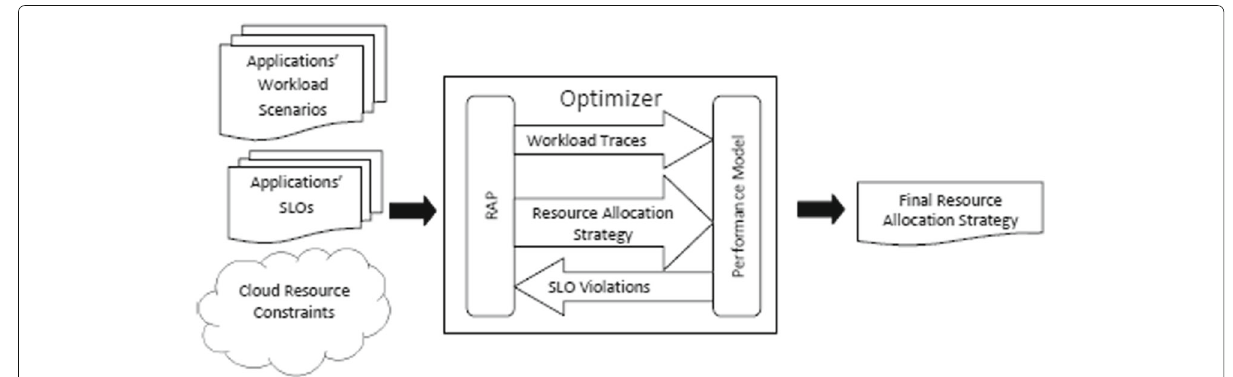
be synthetically generated based on subscriber